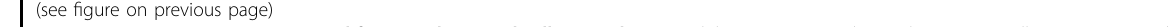
Fig. 5 p38 MAPK activation is critical for autophagy and cell survival. a p38 inhibition suppressed autophagy. A549 cells were pretreated with BIRB796 (20 μ M) and chloroquine (100 μ M) for 1 h before being cultured for 8 h under glucose deprivation. Immunoblotting analyses were performed using the indicated antibodies. b p38 or autophagy inhibition suppressed cell survival. A549 cells were pretreated with BIRB796 (20 μ M) and chloroquine (100 μ M) for 1 h before being cultured under glucose deprivation. Cellular viability was examined by CCK8 assay at 36 h post glucose deprivation treatment. c Exogenous glutamate rescued autophagy in rGFAT1-H577A-expressing cells, but not when TAB1 was depleted. A549 cells with deleted GFAT1 and reconstituted expression of WT rGFAT1 or rGFAT1-H577A were transfected with TAB1 siRNA and cultured for 8 h under glucose deprivation with exogenous glutamate (Ex-Glu). Immunoblotting analyses were performed using the indicated antibodies. d Exogenous glutamate rescued cell survival in rGFAT1-H577A-expressing cells, but not when TAB1 was depleted. A549 cells with deleted GFAT1 and reconstituted expression of WT rGFAT1 or rGFAT1-H577A were transfected with TAB1 siRNA and cultured for 8 h under glucose deprivation with exogenous glutamate (Ex-Glu). Cellular viability was examined by CCK8 assay at 36 h post glucose deprivation treatment. e Autophagy inhibition suppressed cell survival rescued by exogenous glutamate in rGFAT1-H577A-expressing cells. A549 cells with deleted GFAT1 and reconstituted expression of WT rGFAT1 or rGFAT1-H577A were pretreated with chloroquine (100 μ M) for 1 h before being cultured under glucose deprivation with exogenous glutamate (Ex-Glu). Cellular viability was examined by CCK8 assay at 36 h post glucose deprivation treatment. f Exogenous glutamate failed to rescue autophagy in rTAB1-S438A- or rTAB1-E212A-expressing cells. A549 cells with depleted TAB1 and reconstituted expression of WT rTAB1, rTAB1-S438A or rTAB1-E212A were cultured for 8 h under glucose deprivation with exogenous glutamate (Ex-Glu). Immunoblotting analyses were performed using the indicated antibodies. g Exogenous glutamate failed to rescue cell survival in rTAB1-S438A- or rTAB1-E212A-expressing cells. A549 cells with depleted TAB1 and reconstituted expression of WT rTAB1, rTAB1-S438A or rTAB1-E212A were cultured under glucose deprivation with exogenous glutamate (Ex-Glu). Cellular viability was examined by CCK8 assay at 36 h post glucose deprivation treatment. h Chloroquine blocked autophagy rescued by expression of MKK6E in rTAB1-S438A- or rTAB1-E212A-expressing cells. A549 cells with depleted TAB1 and reconstituted expression of rTAB1-S438A or rTAB1-E212A were transfected with MKK6E and pretreated with chloroquine (100 μ M) for 1 h before being cultured for 8 h under glucose deprivation. Immunoblotting analyses were performed using the indicated antibodies. i Chloroquine blocked cell survival rescued by expression of MKK6E in rTAB1-S438A- or rTAB1-E212A-expressing cells. A549 cells with depleted TAB1 and reconstituted expression of rTAB1-S438A or rTAB1-E212A were transfected with MKK6E and pretreated with chloroquine (100 μ M) for 1 h before being cultured under glucose deprivation. Cellular viability was examined by CCK8 assay at 36 h post glucose deprivation treatment. In b , d , e , g , and i , the values are presented as means ± SEM, n = 3; P values (Student ’ s t -test, two-sided) with control or the indicated groups are